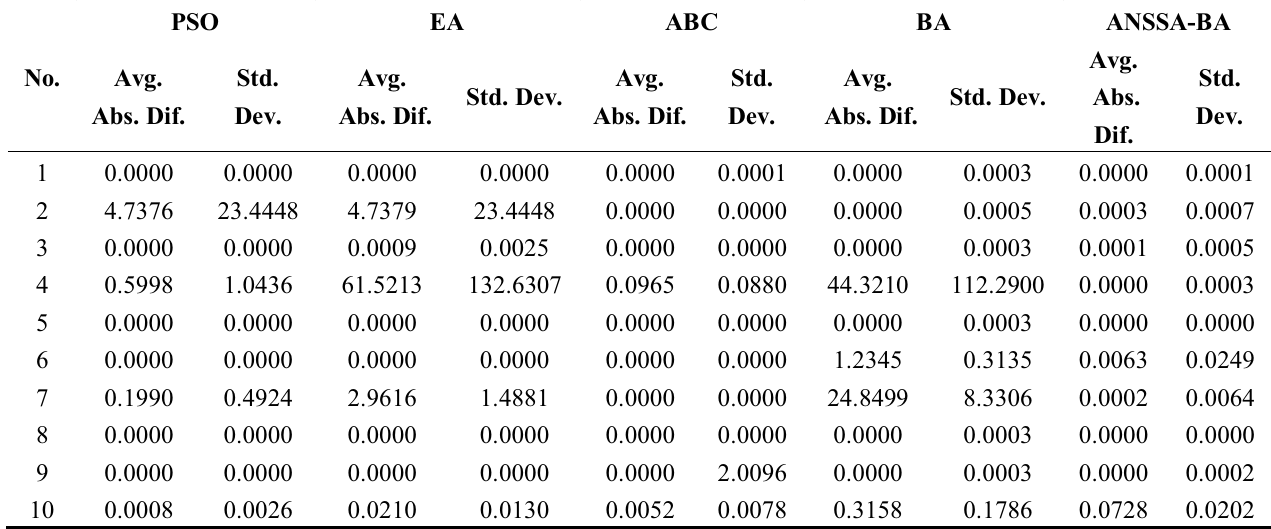
Table 8. Accuracy of the proposed algorithm compared with other well-known optimization techniques.